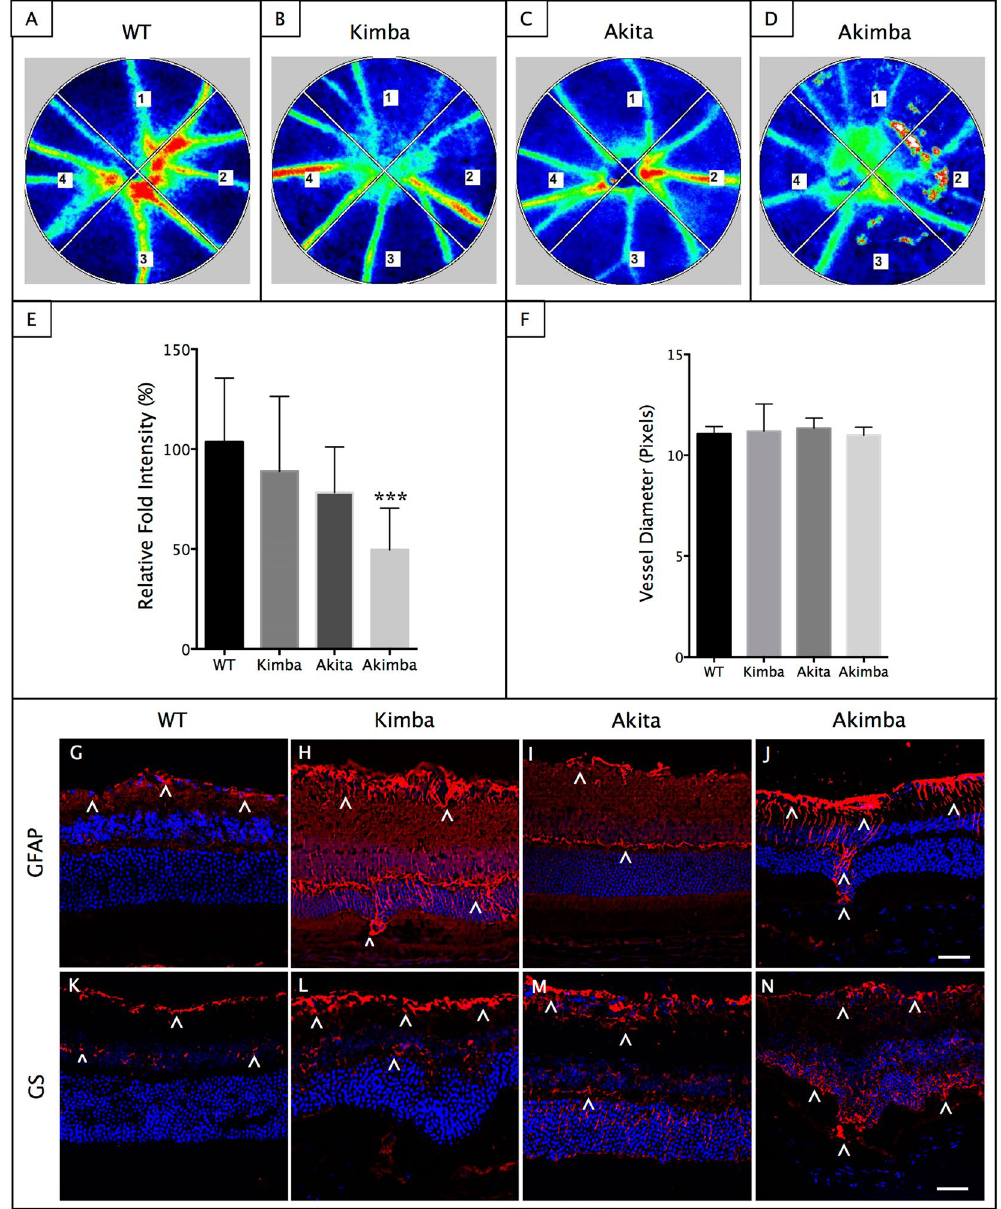
Figure 3. Reduced retinal flow volume and Müller cell gliosis in Akimba mouse. Laser speckle flowgraphy (LSFG) heat map of retinal blood flow in the animal models ( A – D ). Red indicates faster blood flow while blue indicates slower blood flow. Numbers 1–4 denotes four quadrants of the retina used for the analysis. Assessment of relative flow volume in the all four quadrants depicted significant attenuation of blood flow in Akimba ( D, E ). No differences were seen between the Kimba and Akita mice ( E ). Measurement of vessel diameter showed no difference in caliber amongst all four groups ( F ). Data represent mean ± SD. n = 6 animals in each group. *** p < 0.001 compared to the WT. Akimba mouse showed maximal GFAP ( J ) stained cells compared with WT ( G ) or the parental strains ( H , I ). Similarly, GS immunostaining was observed throughout the entire inner retina and few cells migrating to the outer retina in the Akimba mice ( N ). Kimba retina showed similar staining patter but less intense ( L ) followed by Akita, where we found staining restricted to the inner retina ( M ) compared to the WT ( K ). n = 4 retina per group for immunohistochemistry, repeated twice. Arrowheads indicate positively stained cells. Scale bar, 50 µ